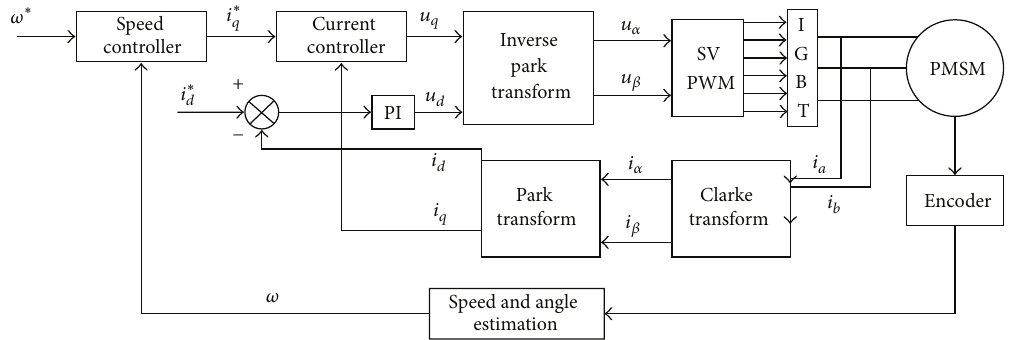
Figure 1: The principle block diagram of PMSM system based on vector